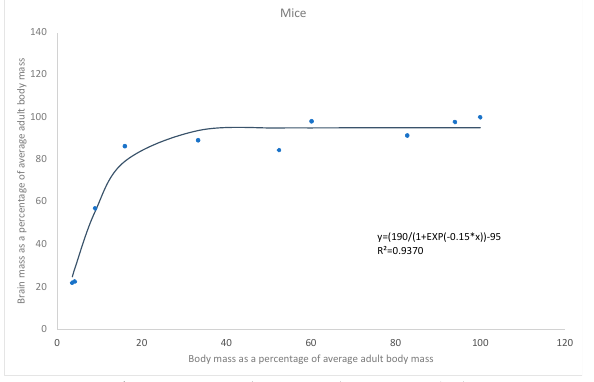
( h ) Brain growth in mice (Mus musculus) . Figure 2. ( a ) Data from Figure 2b–h. ( b ) Data from Passingham, 1975; Harel et al., 1972 [4,30]. ( c ) Data from Count, 1947; Dobbing and Sands, 1973; Connolly, 1950; Spector, 1956; Dickerson et al.;